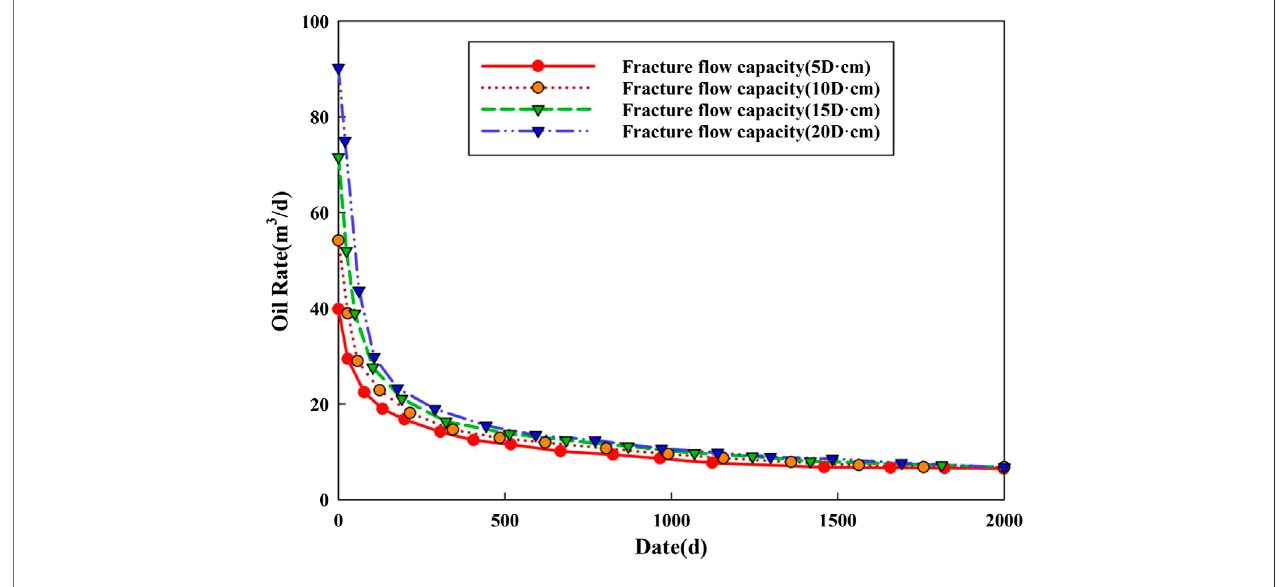
FIGURE 15 | Daily oil Production Curve of Different Fracture Flow Capacity.